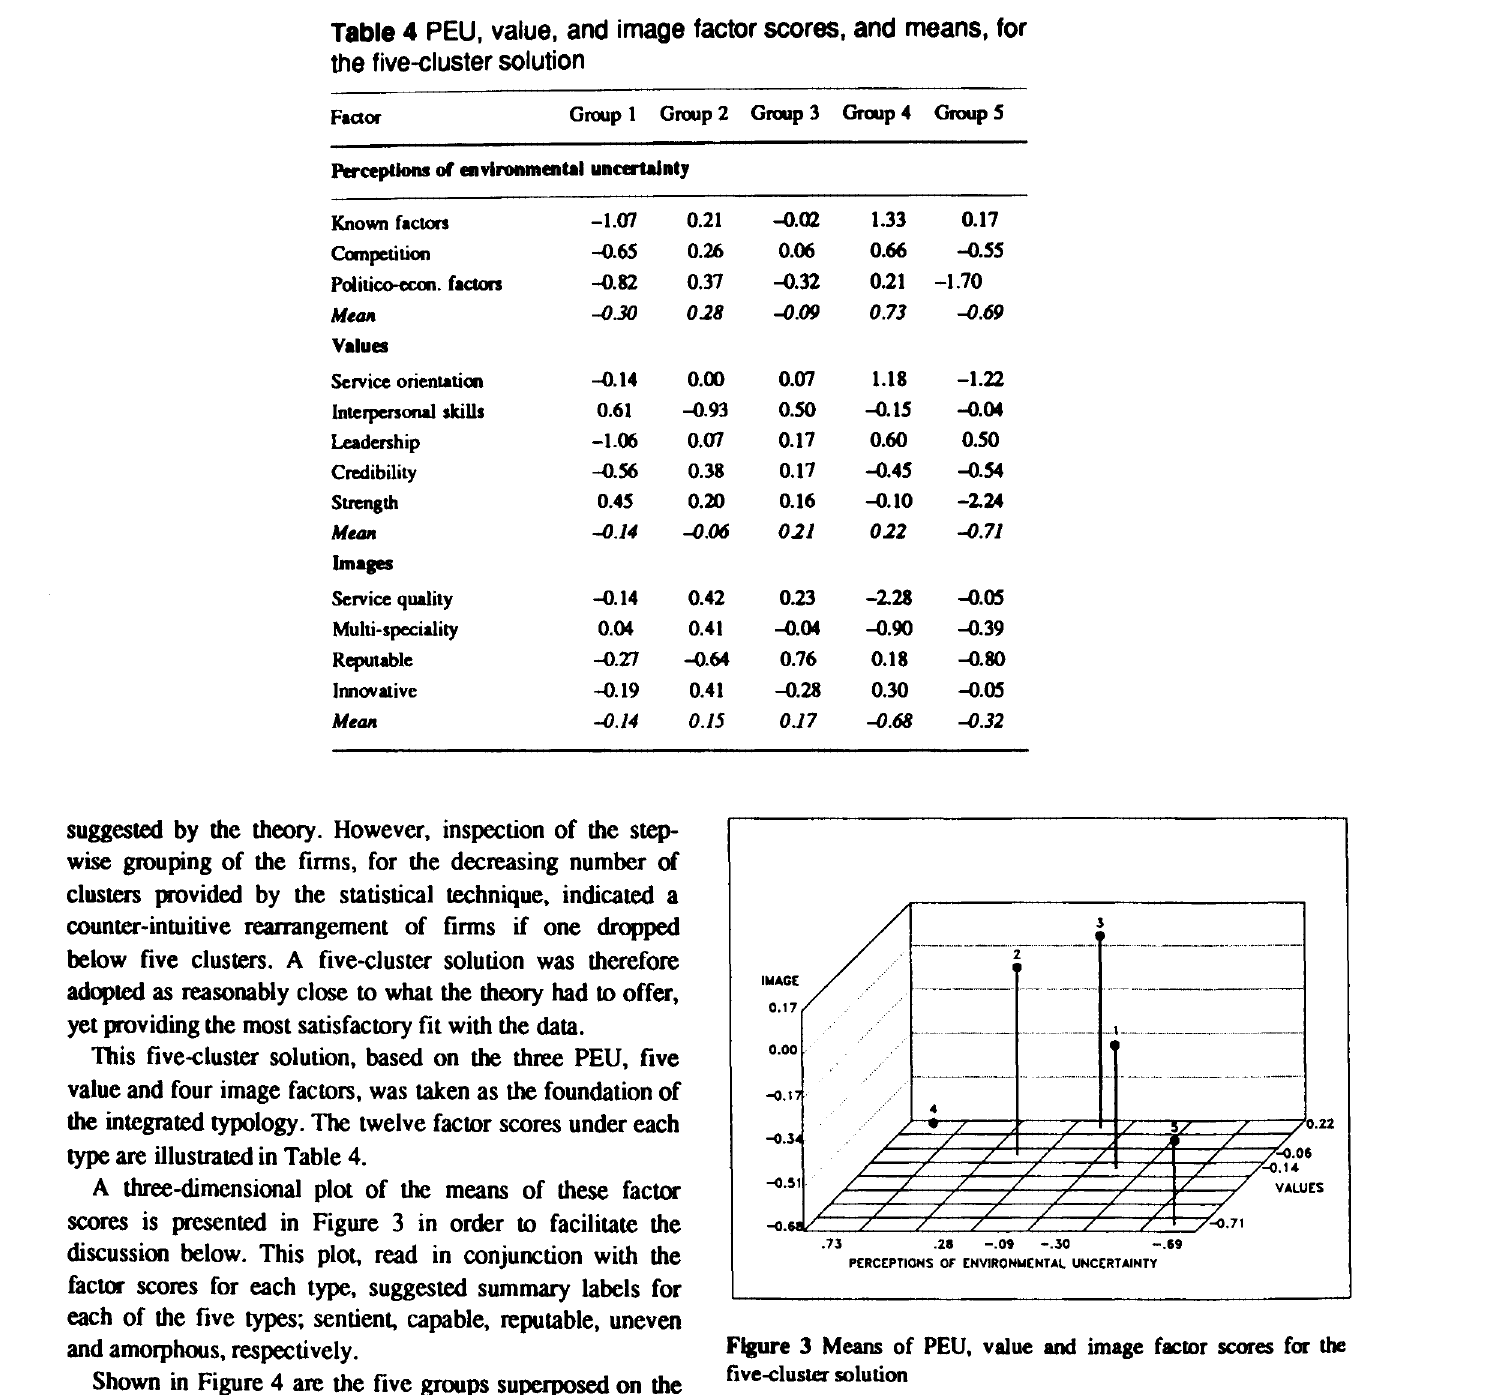
Figure 3 Means of PEU, value and image factor scores for the five-cluster